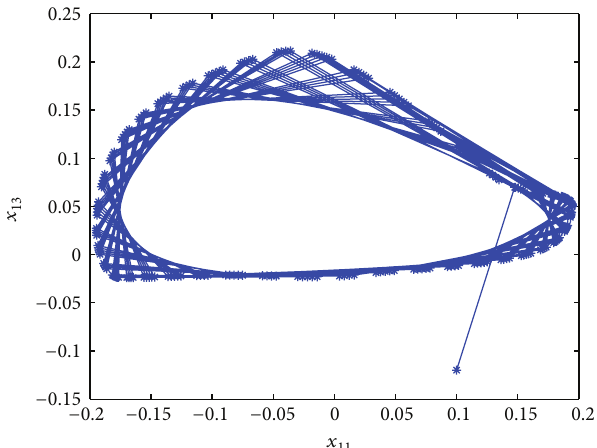
Figure 5: Phase response of state variables 𝑥 11 , 𝑥 13 in Example 2.